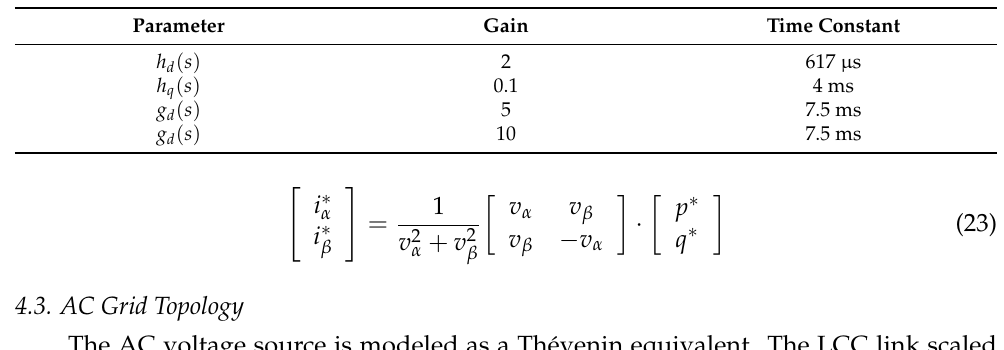
Table 2. Control circuit parameters.